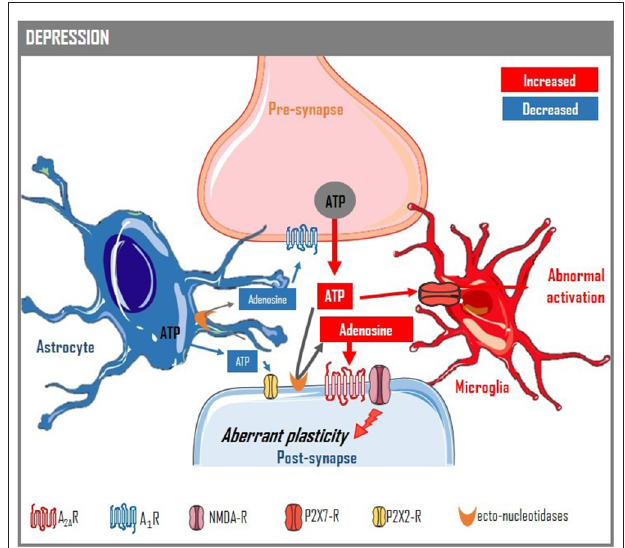
FIGURE 2 | Purine-based control of glia-neuron bidirectional communication in depression. Associated with astrocytic hypofunction in depression, there is a lower release of ATP and adenosine from astrocytes (Cao et al., 2013; Hines et al., 2013). This causes a deficient astrocyte-to-neuron activation of P2X2 (ATP) receptors (Cao et al., 2013) and a deficient activation of inhibitory adenosine A 1 receptors in neurons (Serchov et al., 2015), which density decreases upon chronic stress (Cunha et al., 2006; Kaster et al., 2015). In parallel, there is an increased excitability (increased noise), which bolsters the synaptic release of ATP (Cunha et al., 1996), an up-regulation of synaptic adenosine A 2A receptors (Cunha et al., 2006; Batalha et al., 2013; Kaster et al., 2015), which is associated with aberrant plasticity (Li et al., 2015), and an up-regulation of microglia P2X7 receptors, which contributes to microglia hyper-responsiveness upon depression (Stokes et al., 2015). This illustrates the role of the purinergic system in the control of the homeostasis of the quad-partite synapse and shows that maladaptive changes in the purine neuromodulation system occur upon depression that can be exploited therapeutically, such as increasing the release of ATP and adenosine from astrocytes, decreasing the neuronal activation of A 2A receptor or bolstering the neuronal activation of A 1 receptors or inhibiting microglia P2X7 receptors.